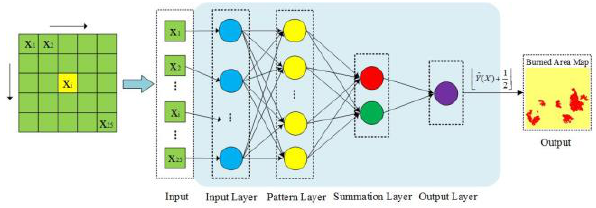
Figure 3. Architecture of the GRNN model used in this study